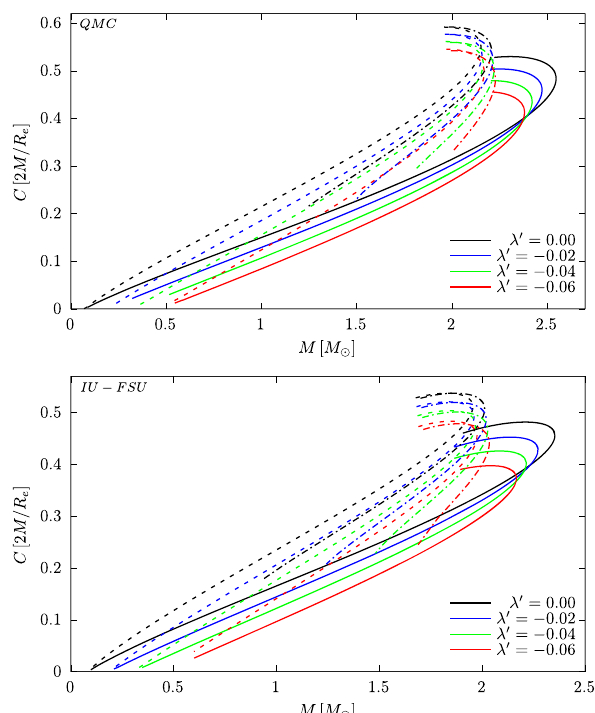
Fig. 6 The compactness C for non-rotating stars (dashed curves), stars rotating at 716 Hz (dash-dot curves) and for stars rotating at the mass- shedding limit (solid line curves). The curves for λ (cid:6) = 0 correspond to the GR